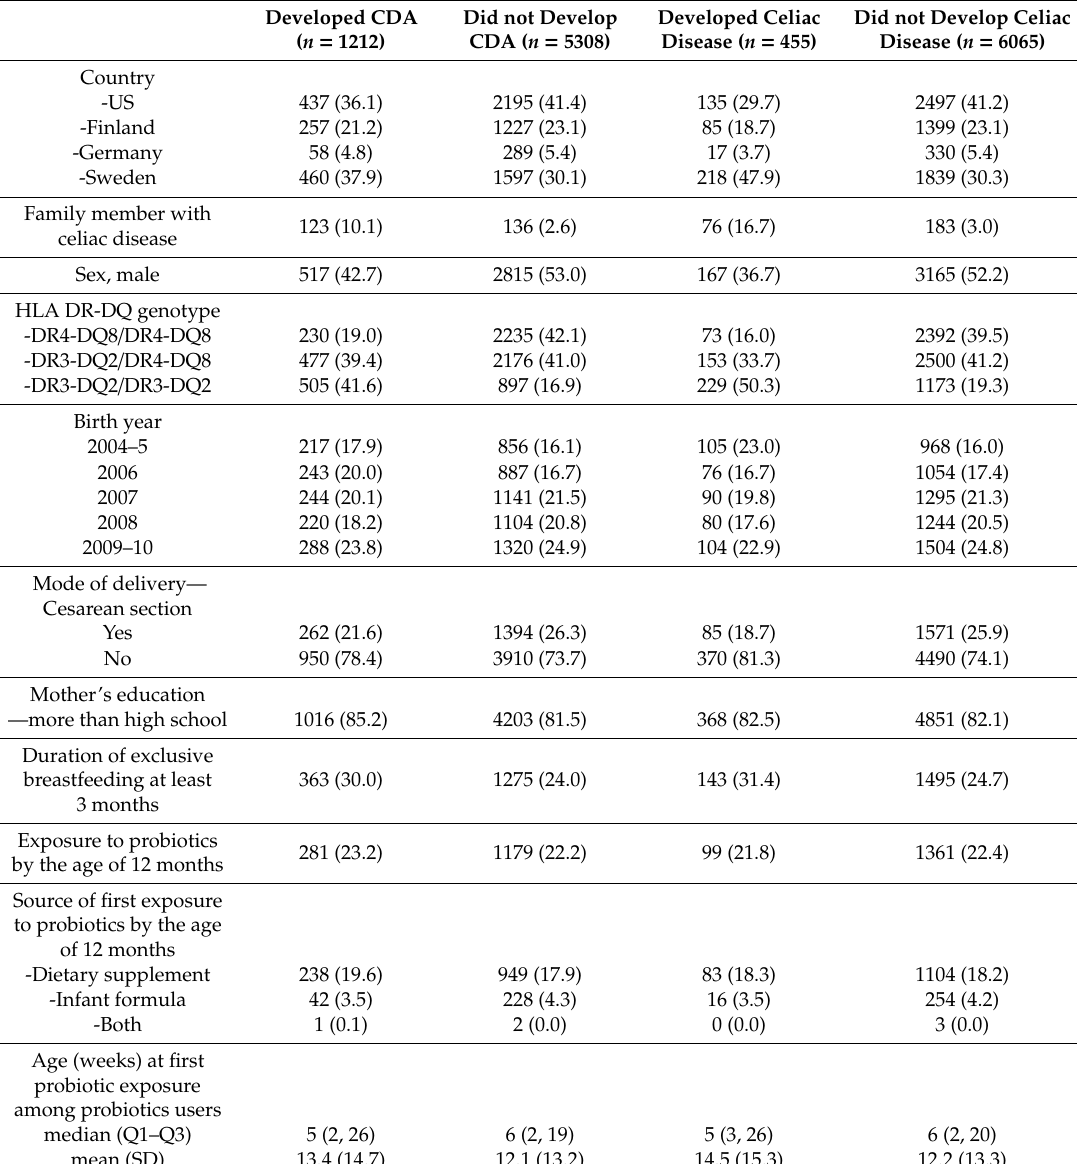
Table 1. Characteristics of the study participants by status of celiac disease autoimmunity (CDA) and of celiac